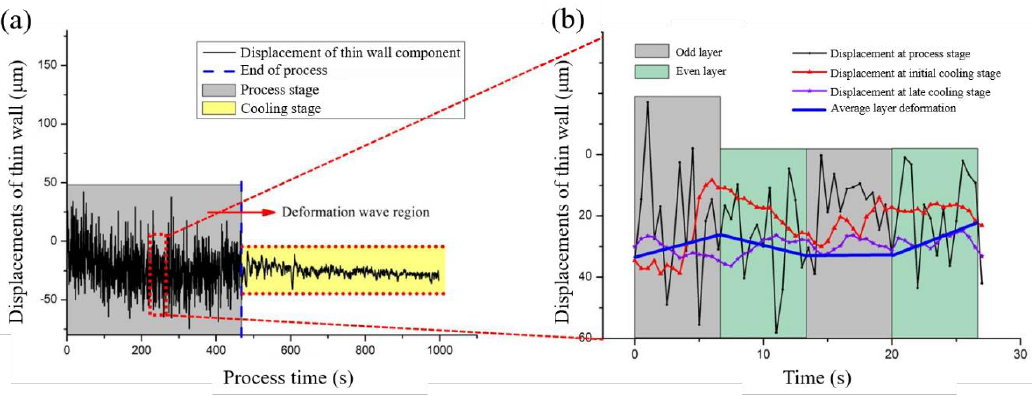
Figure 6. Real time deformation monitoring of the measured middle points on thin-wall sample with the length of 40 mm. ( a ) deformation measurement results in the whole process; ( b ) deformation